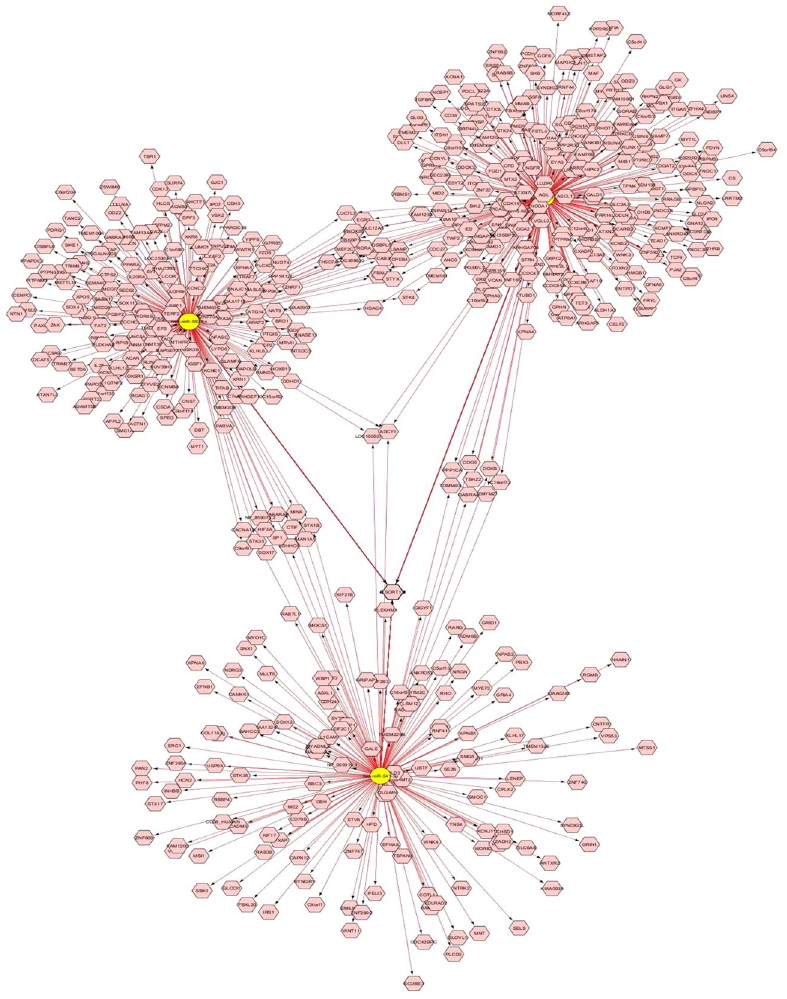
Figure 4. Gene regulatory network of top 3 upregulated miRNAs based on TargetScan target prediction algorithm. Construction of an integrated target gene regulatory network is shown, which was based on the TargetScan derived predicted target genes for top three significantly upregulated miRNAs (miR-541-3p, miR- 550-5p and miR-1179). The selection of miRNAs was based on the magnitude of upregulated expression in the suicide group ( ≥ 1.5 cutoff in relative fold